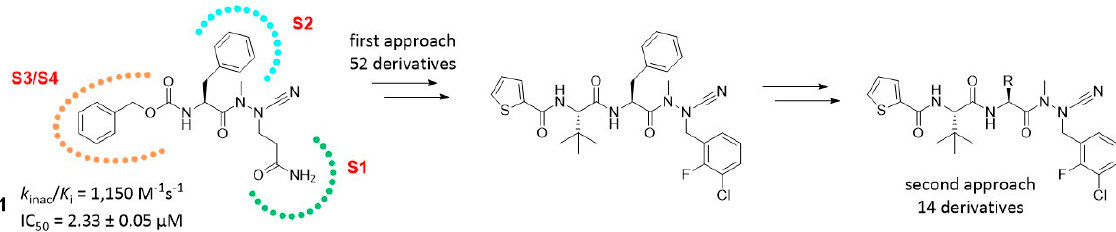
Figure 40. Optimization procedure from the irreversible SARS-CoV-2 Mpro inhibitor 1 to potent, new derivatives.